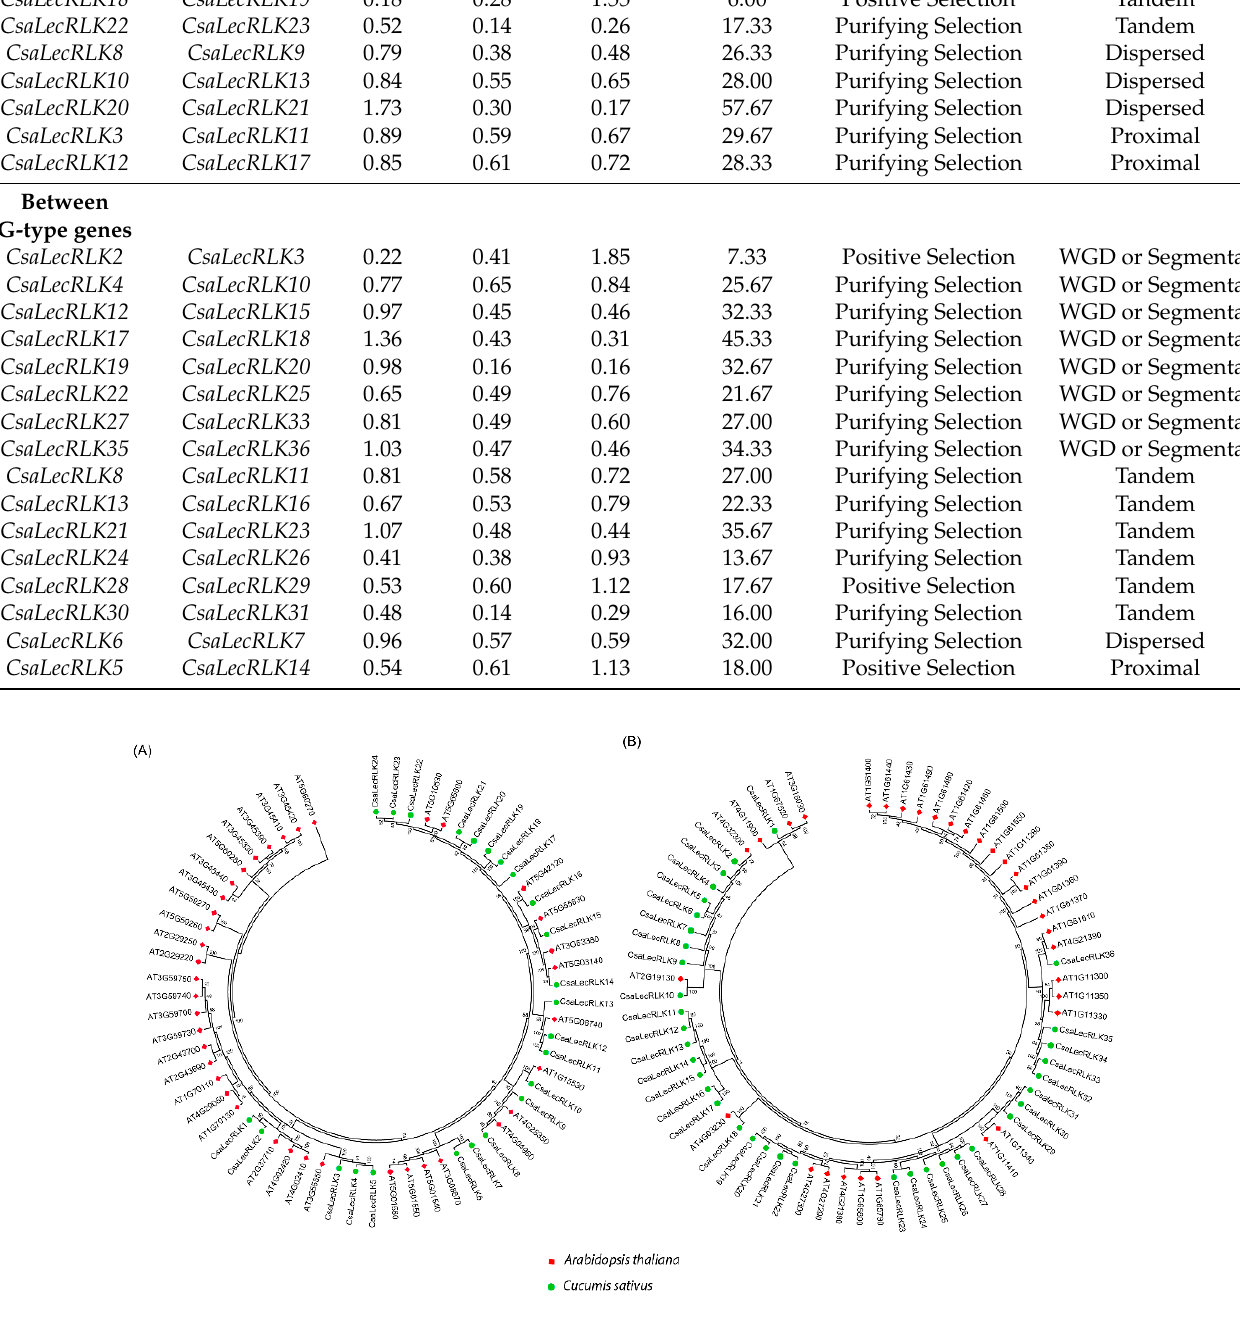
Figure 1. Phylogenetic analysis of ( A ) L-type LecRLK and ( B ) G-type LecRLK proteins between cucumber and Arabidopsis . The phylogenetic tree was constructed using MEGA (7.0) software with the maximum likelihood (ML) method with 1000 bootstrap values.